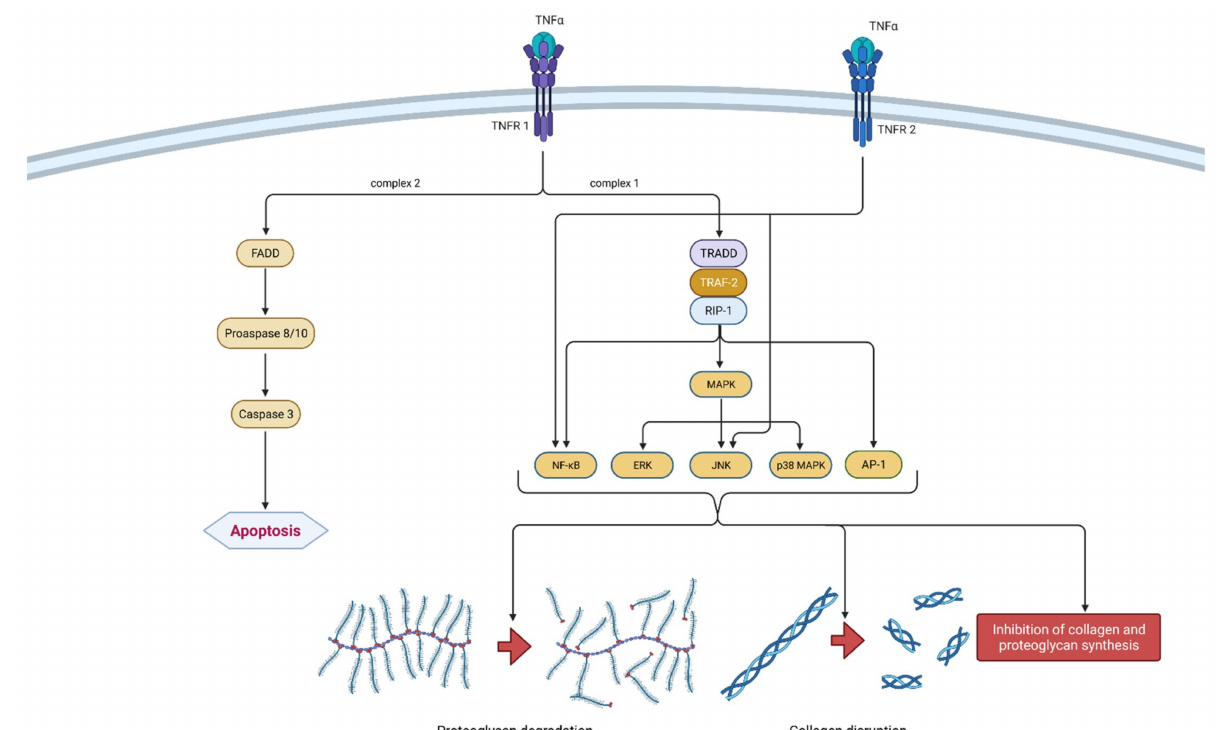
Figure 3. Schematic representation of TNF- α function in osteoarthritis pathogenesis. TNF- α can bind to two receptors, TNRF-1 and TNRF-2. By binding to TNRF-1, TNF- α can induce two different signaling complexes. Complex 1 leads to the stimulation of cell survival and the expression of NF- κ B, MAPK and AP-1, which results in proteoglycan degradation, collagen disruption and the inhibition of proteoglycan and collagen synthesis. On the other hand, the activation of complex 2 leads to a cascade of reactions, which include the formation of FADD and the activation of procaspase 8/10 and caspase 3, which consequently leads to cell apoptosis. Additionally, the binding of TNF- α to TNRF-2 activates NF- κ B and JNK. In summation, TNF- α leads to degeneration of cartilage and other joint structures, thus contributing to the onset and progression of osteoarthritis. TNF- α —tumor necrosis factor α ; TNRF-1—Tumor necrosis factor receptor 1; TNRF-2—Tumor necrosis factor receptor 2; TRADD—TNFR-1 associated death domain protein; RIP-1—receptor